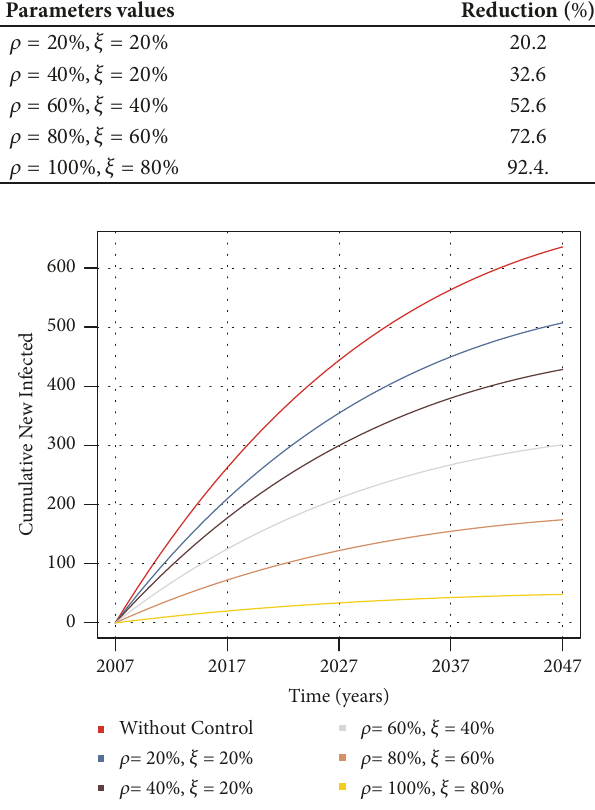
Figure 6: Sensitivity analysis on the cumulative number of newly infected by applying combined control: increasing proportion of treatment in infected newborns (parameter 𝜌 ) and on the surveil- lance in blood transfusion transmission (parameter 𝜉